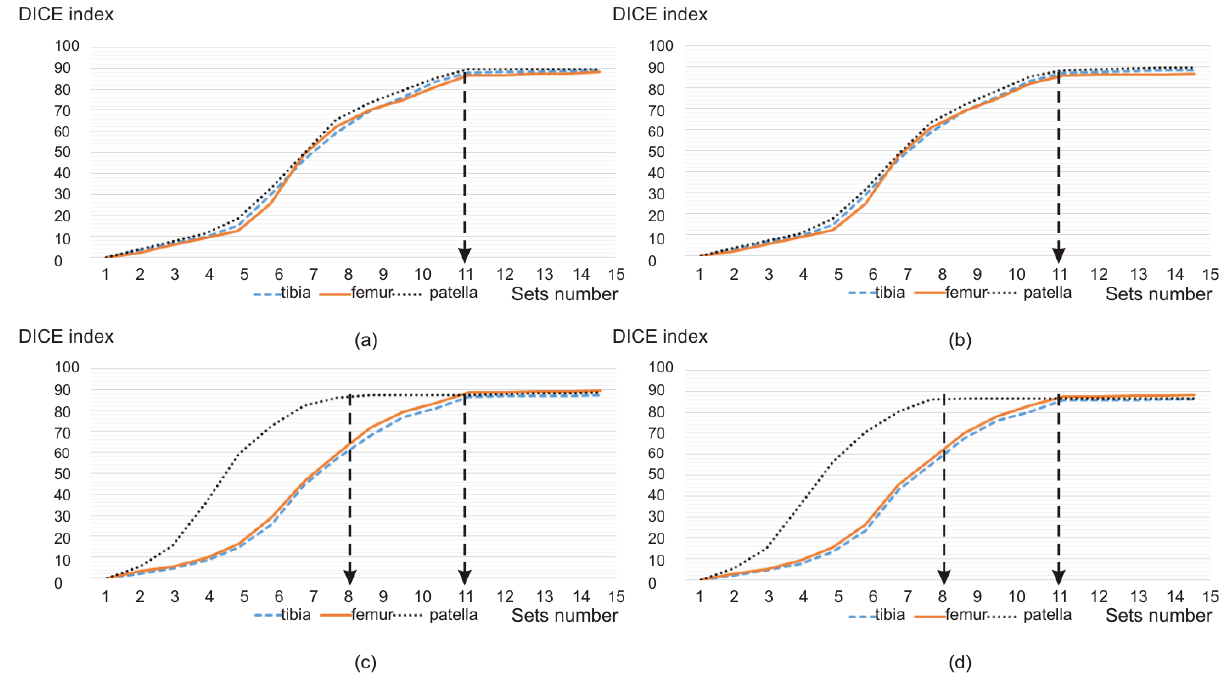
Figure 3. Dependence of the DICE index value on the sets number for ( a ) CT scans on the transverse plane and the FC method, ( b ) CT scans on the transverse plane and the FCM method, ( c ) MRI scans on the sagittal plane and the FCM method, and ( d ) MRI scans on the sagittal plane and the FCM method. The last step allows for the average features to be obtained by each of the 11 sets.